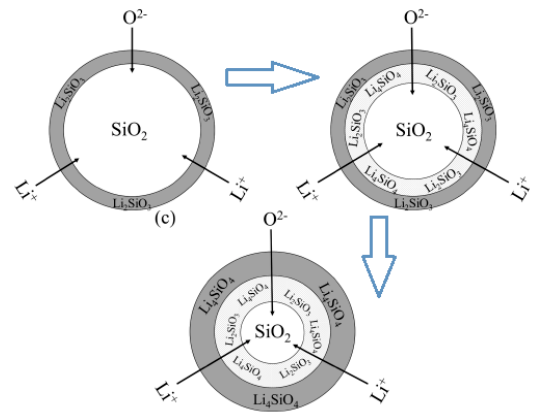
Figure 2. Core-shell model for synthesis of Li 4 SiO 4 by the solid-state route [24].